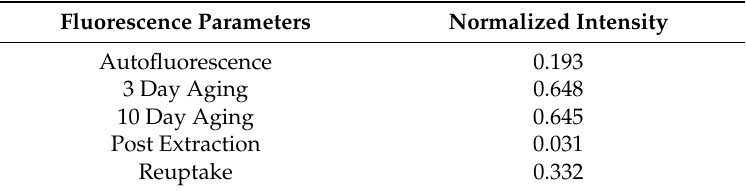
Table 5. Summary of different fluorescence parameters tested and their